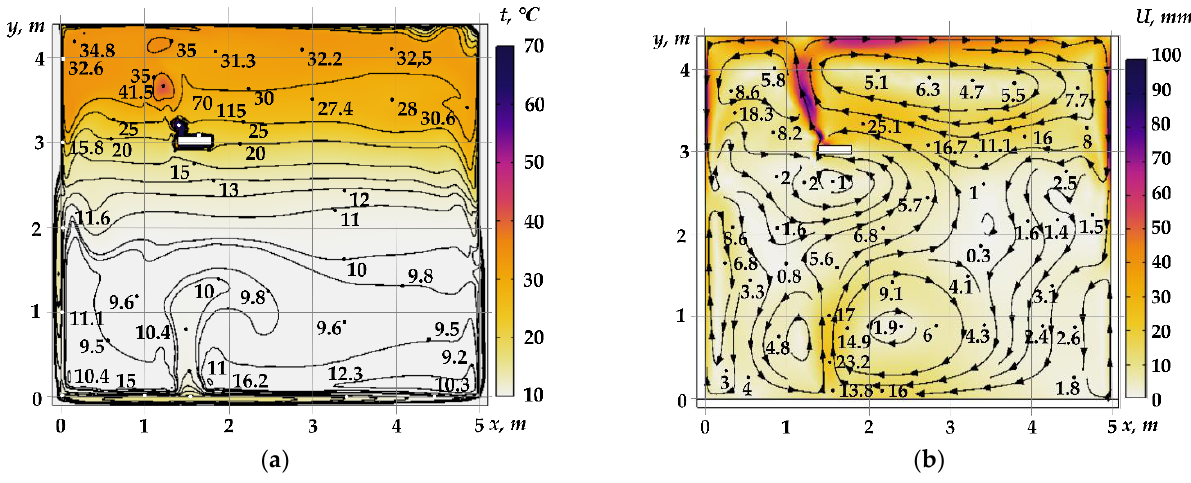
Figure 7. ( a ) Temperature fields (positions of characteristic isotherms) and ( b ) streamlines for an area without a panel after τ = 60 min of GIH operation.